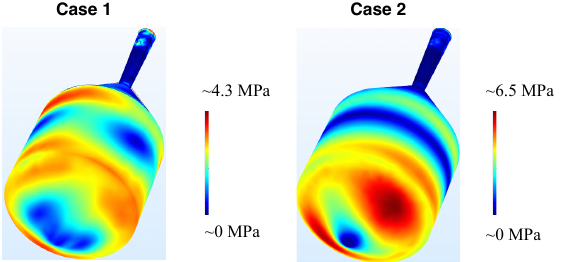
Figure 9. Von Mises stress for Case 1 ( left ) and Case 2 ( right ), the deformation of the geometry is claryfied by a magnification factor ( left ): 100; ( right ): 20. Thermal expansion coefficients used as measured by us. The thin black lines of the shorter undeformed crystal geometry are painted over by the color graphics: the displacements due to the different temperatures are visualized by the surface with the colours of the von Mises